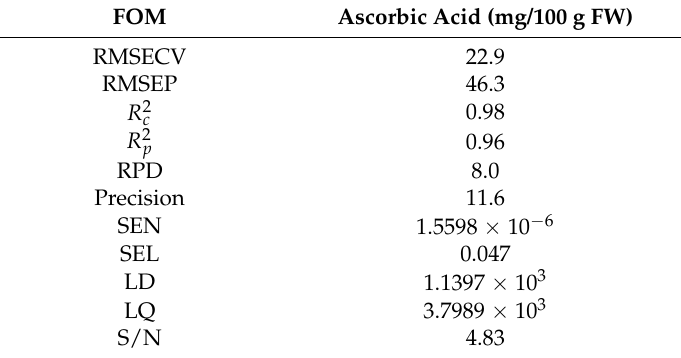
Table 4. Figures of merit for the best performing GA-PLS z model of ascorbic acid in intact